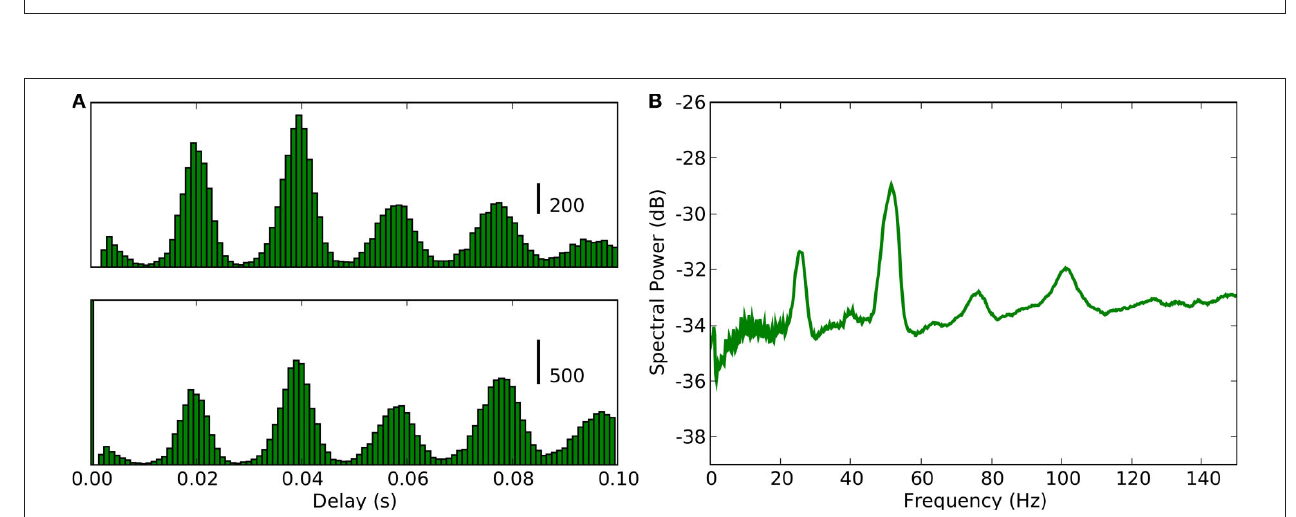
(B) Phase distribution of EPSPs relative to band passed (51.5 ± 2 Hz) membrane potential (top) and to line noise (60 ± 0.1 Hz) (bottom). (C) Spectra of membrane potential (black), spikes (red) and EPSPs (blue) recorded during the presentation of a natural movie; the spectral peak is at 52 ± 2 Hz. (D) Spectra obtained from recordings of the same cell as in (A–C) , but with the eyes occluded; the peak frequency is slightly lower, 48 ± 2 Hz than when the eyes were open.